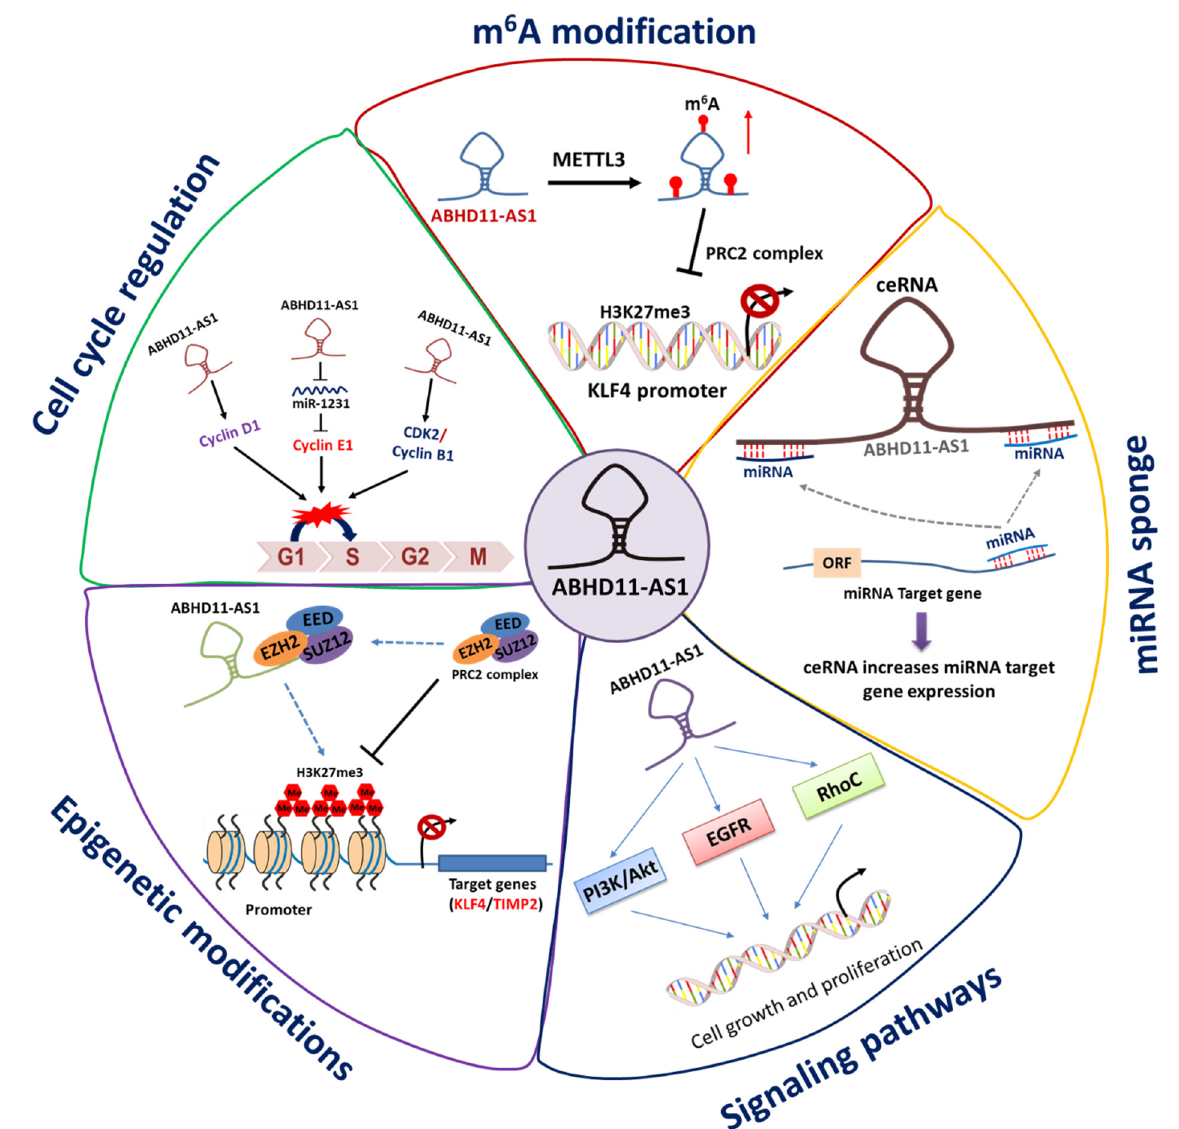
Figure 4. The molecular mechanisms of ABHD11-AS1 lncRNA play critical role in contributing to tumorigenesis and progression. ABHD11-AS1 act as a ceRNA (sponge miRNAs), undergoes m 6 A modification, and modulates the cell cycle, signaling pathways, and epigenetic modifications to regulate biological functions.